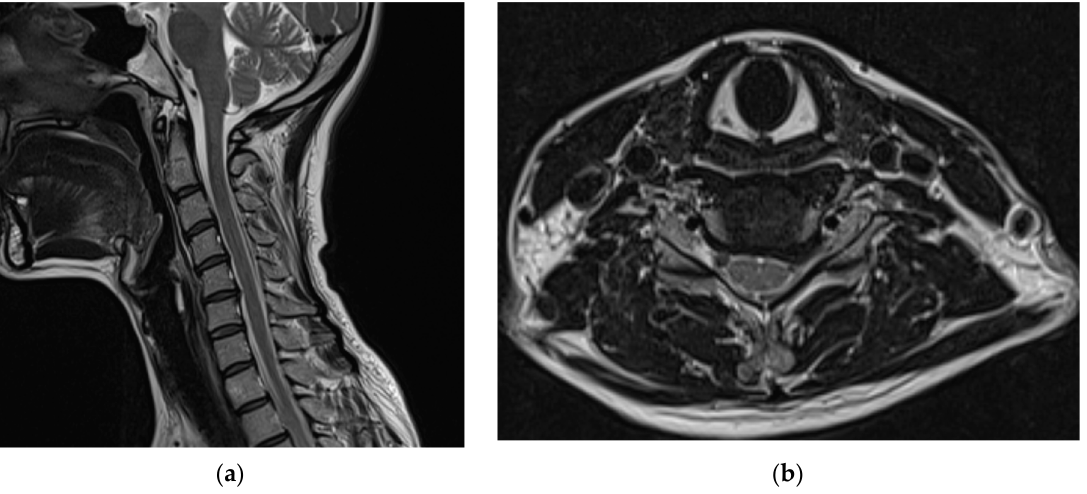
Figure 1. Cervical spine magnetic resonance images obtained before the procedure. A herniated intervertebral disc at the C5/6 level and left C6 nerve impingement due to a left foraminal extrusion are observable on the ( a ) T2-weighted sagittal image and ( b ) T2-weighted axial image of the C5/6 level.